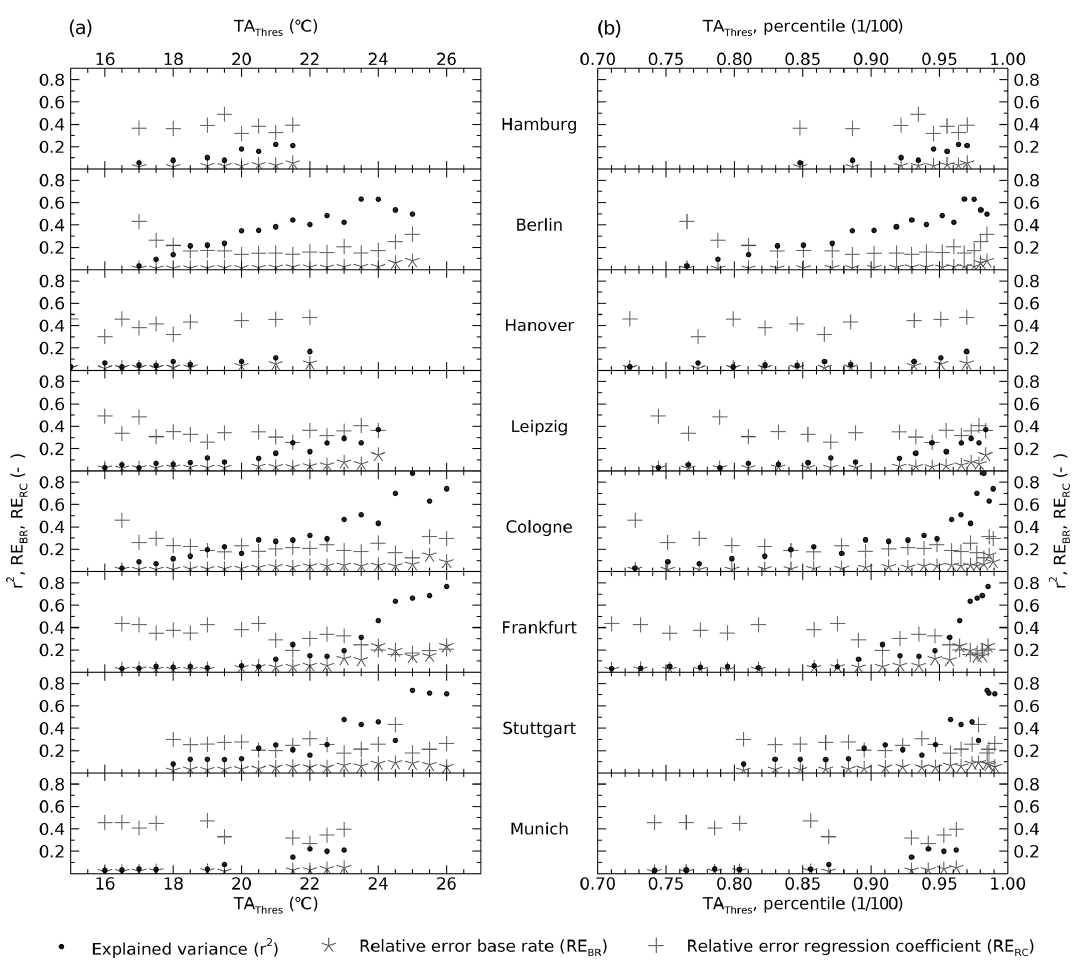
Figure 2. Statistically significant results ( p < 0.05, t test) from the univariate regression analysis with TA Mag as predictor variable for each city: (a) x axis: absolute threshold value for HWE detection (TA Thres ) and (b) x axis: percentile of TA Thres referring to the whole analysis period 2000 to 2017. y axis: explained variance of the models ( r 2 ), relative errors of the base rate (RE BR ) and the regression coefficient (RE RC ),